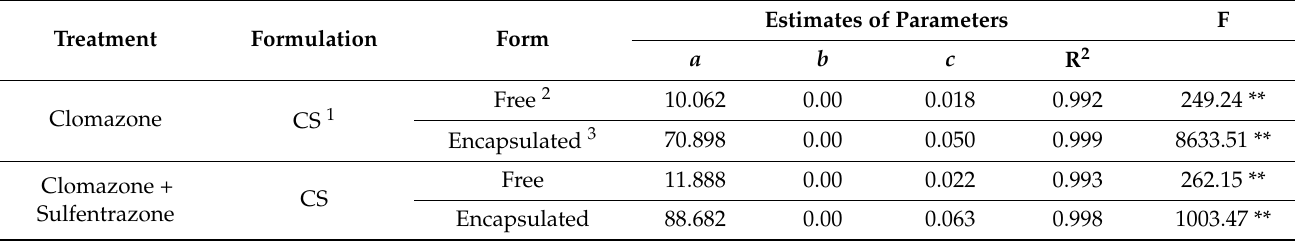
Table 4. Estimates of parameters of Mitscherlich models fitted for the correlation of quantity of clomazone percolated through sugarcane straw with the different simulated rainfall depths (mm), after application of a microencapsulated formulation (single or combined with